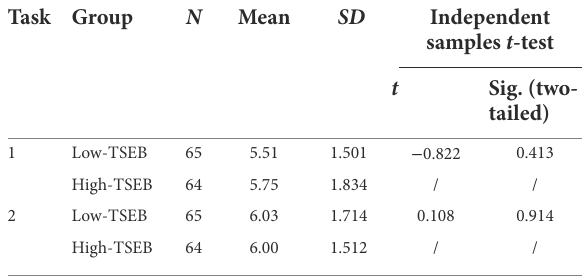
TABLE 4 Independent samples t -test for mental demand subscale.